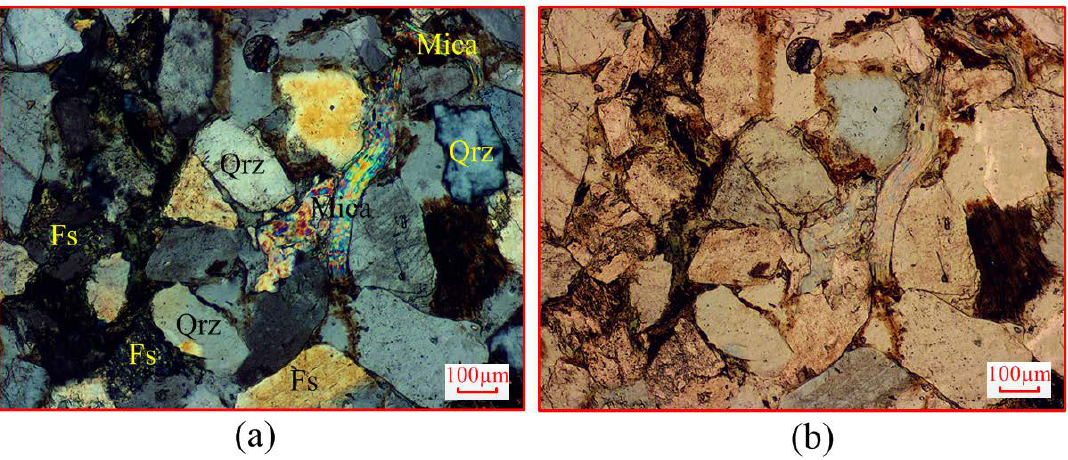
Figure 2. Microscopic pictures of the thin sections of the sandstone: ( a ) photomicrograph under cross-polarized light and ( b ) photomicrograph under plane-polarized light. The major mineral compositions are marked in the picture. Feldspar, quartz and mica are marked as “Fs”, “Qrz” and “Mica” in the picture, respectively.